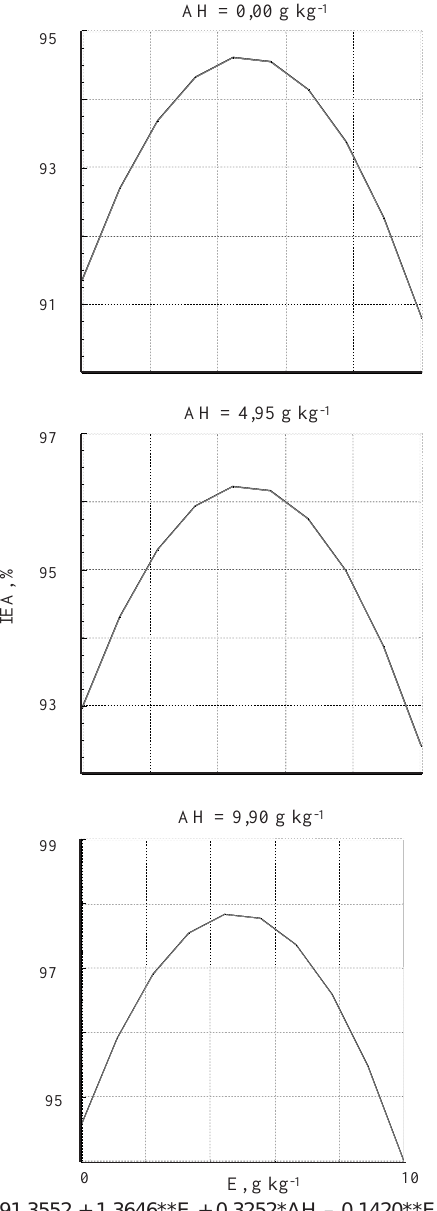
Figura 7. Índice de estabilidade de agregados (IEA) dos agregados do horizonte A analisado por via úmida, considerando a adição de ácido esteárico (E), para diferentes doses de ácido húmico